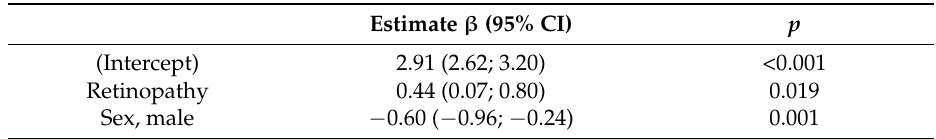
Table 4. Multivariable linear regression model for hypoglycaemia frequency perception of the Diabetes Treatment Satisfaction Questionnaire-status